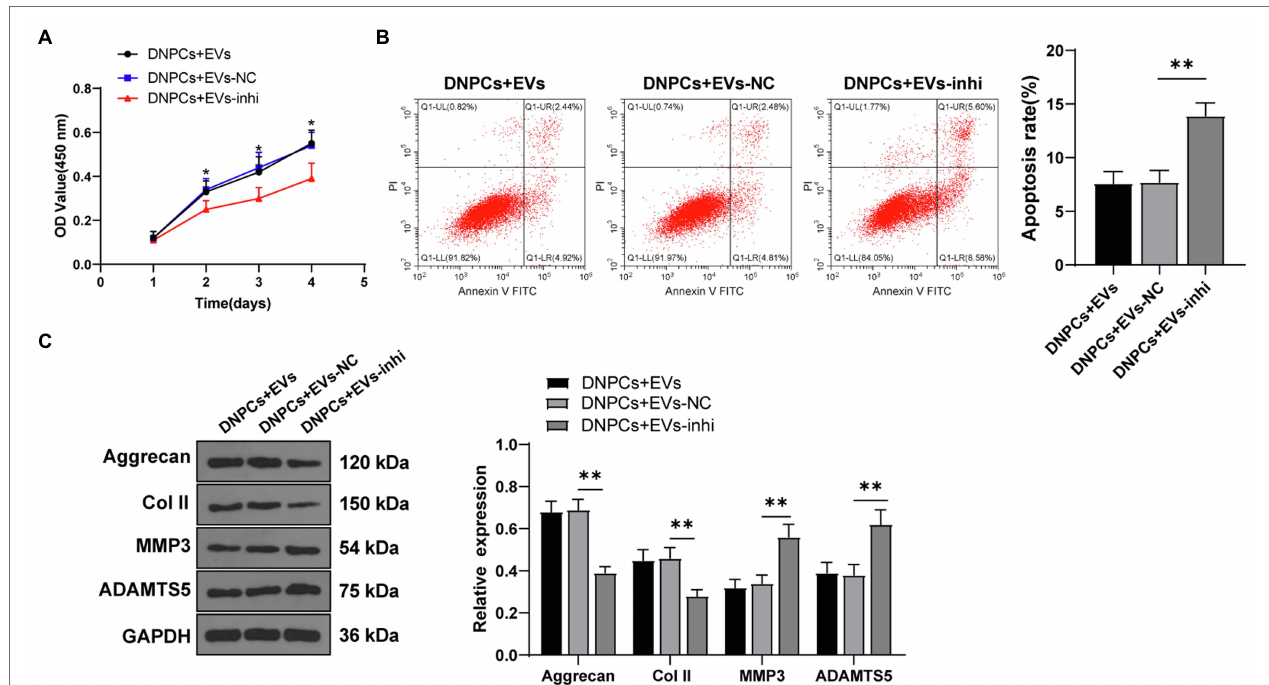
FIGURE 4 | Silencing miR-129-5p inverted the promoting effect of EVs on DNPCs proliferation and ECM synthesis. (A) DNPCs proliferation detected by CCK-8 assay; (B) DNPCs apoptosis detected by flow cytometry; (C) expressions of ECM synthetic genes Aggrecan and Col II and ECM degrading genes MMP3 and ADAMTS5 detected by Western blot. Cell experiment was repeated three times. Data were presented as mean ± standard error. Comparisons among groups were analyzed using one-way ANOVA, followed by Tukey’s multiple comparisons test. * p < 0.05, ** p <